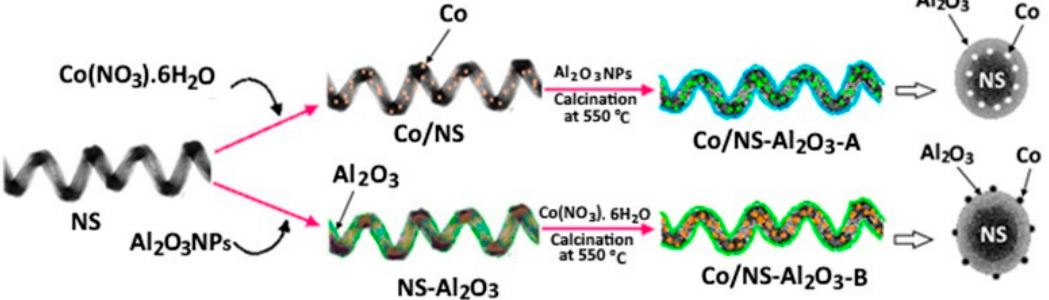
Figure 1. Schematic showing the preparation of the two Co / NS-Al 2 O 3 catalysts: Co / NS-Al-A and Co / NS-Al-B.